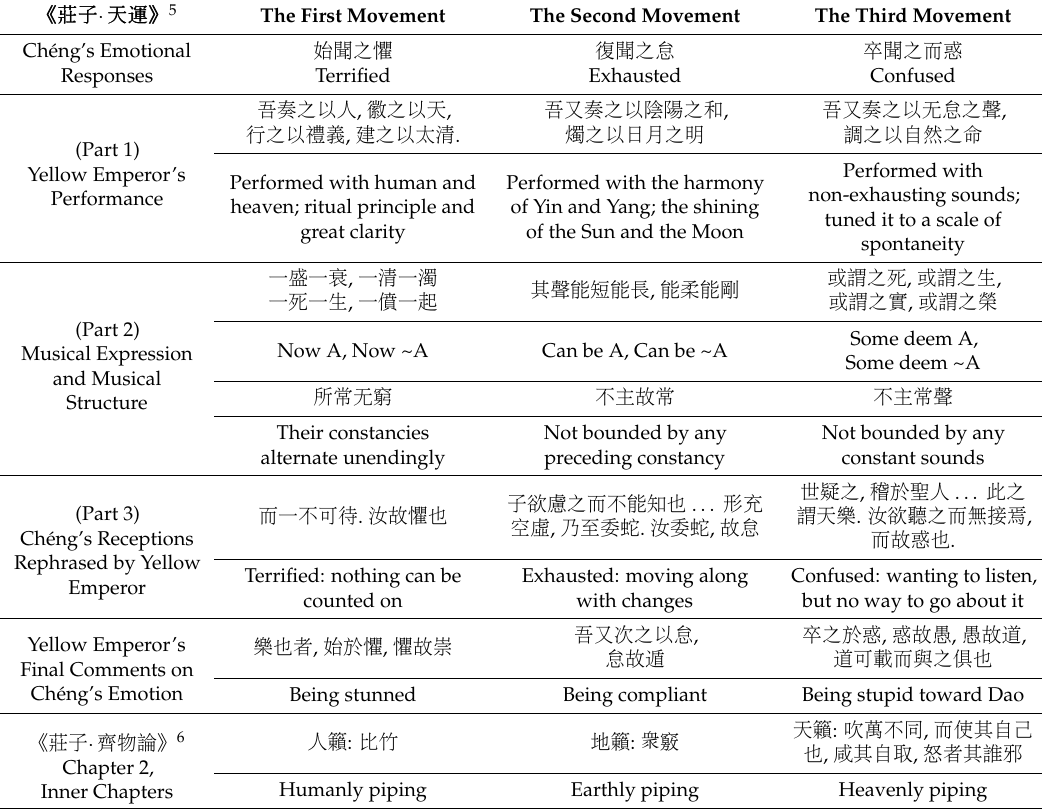
Table 1. Three steps for achieving Dao in the Xiánchí music story and the Inner Chapters. 《莊子 ∙ 天運》